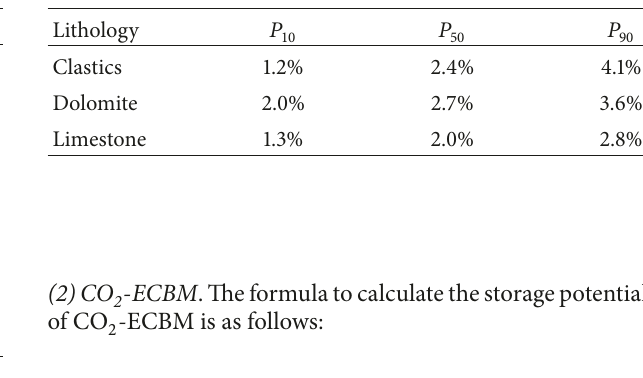
at regional scales saline